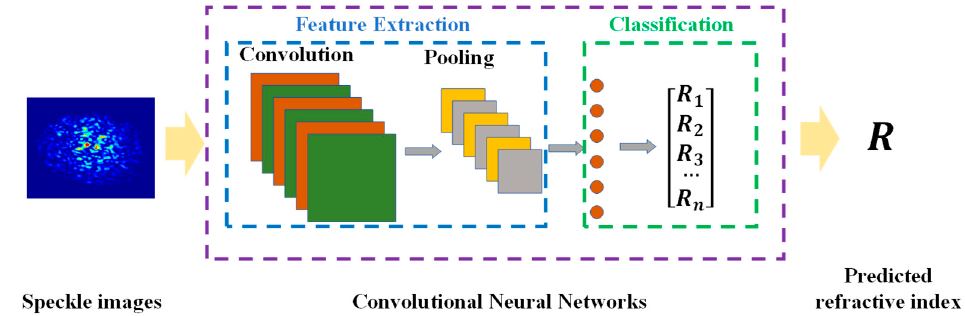
Figure 1. Overview of refractive index recognition scheme based on convolution neural network.